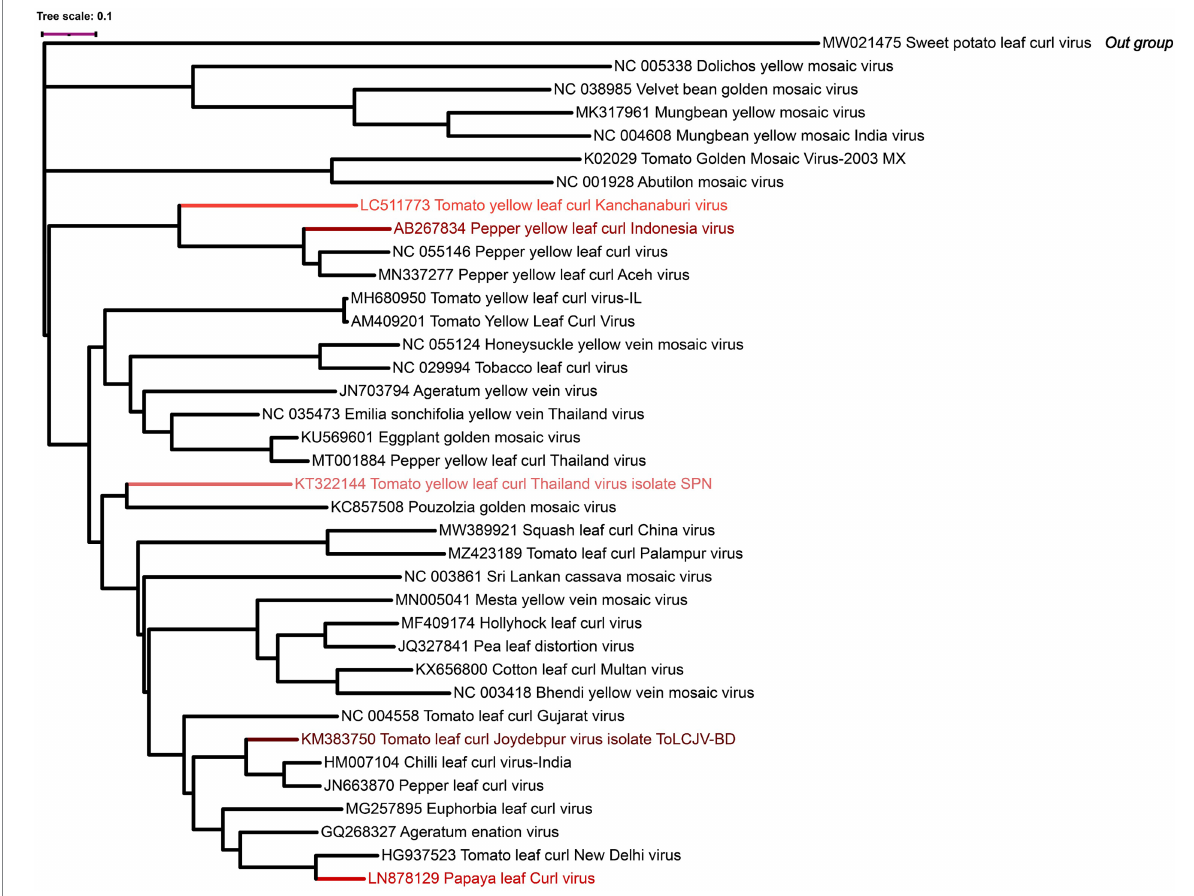
FIGURE 7 Phylogeny of DNA-A: The DNA-A sequences of different endemic begomoviruses were downloaded and assembled by Muscle Alignment module in MEGA-11. The phylogeny was constructed by maximum likelihood method with 500 bootstrap replications. The resulting tree was exported and visualized in iTOL (Letunic and Bork,